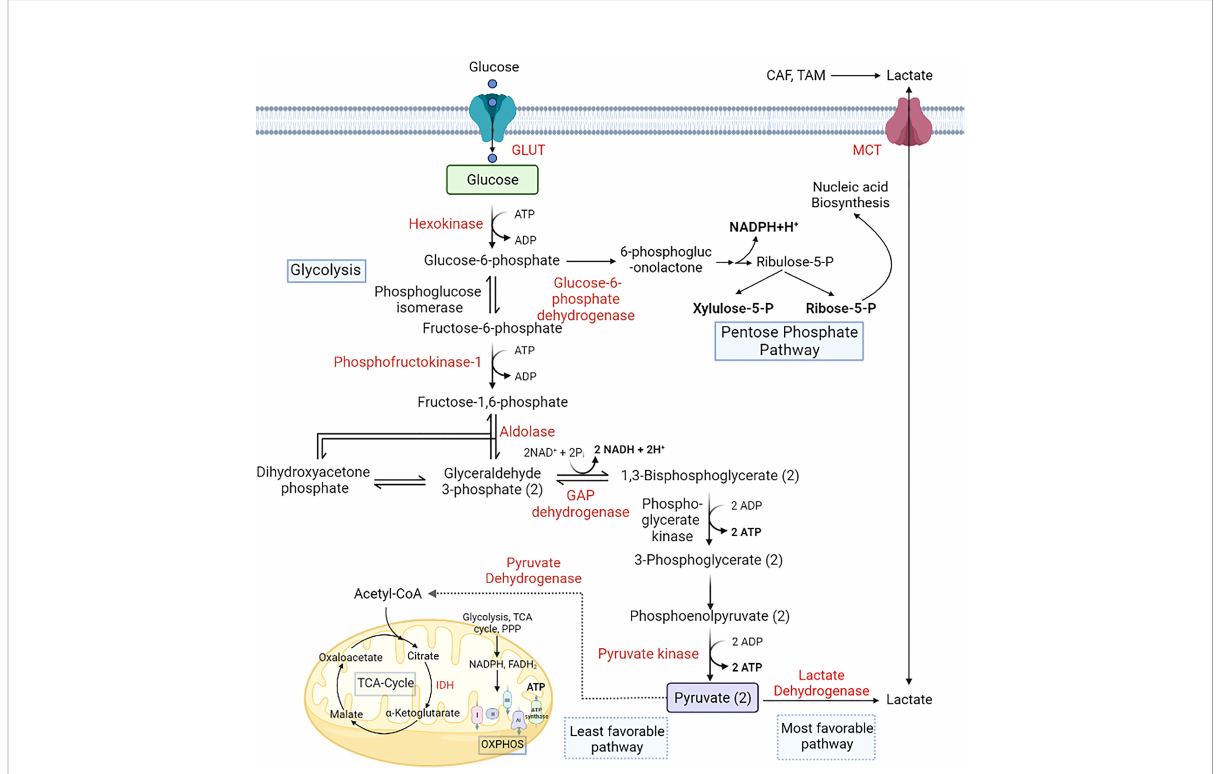
FIGURE 2 Alterations in glucose metabolism during cancer progression. Cancer cells utilize glucose as a primary energy source. GLUT overexpression helps the cells to uptake more glucose from the microenvironment, which is converted to lactate-by-lactate dehydrogenase. Lactate produced by the cells is secreted into the microenvironment via the upregulation of MCT1. PPP is also upregulated in cancer cells to produce NADPH and pentose phosphate for nucleic acid synthesis (18, 96, 97). [GLUT, Glucose transporter; IDH, Isocitrate dehydrogenase; MCT, Monocarboxylate transporter; OXPHOS, Oxidative